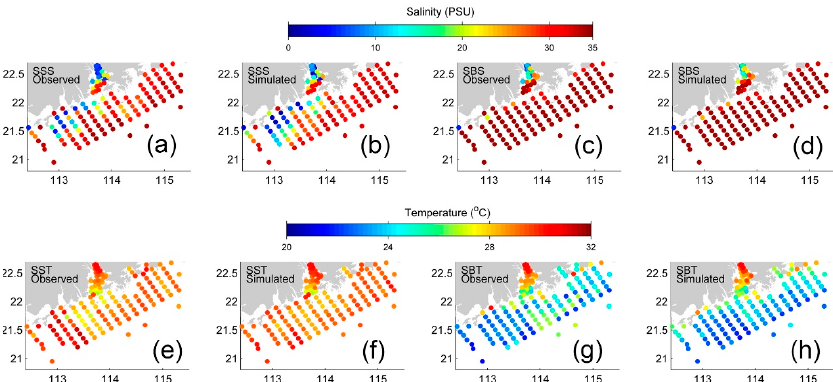
Figure 5. Comparisons of the observed and simulated salinity ( a – d ) and temperature ( e – h ) during summer 2006. SSS: Sea Surface Salinity, SBS: Sea Bottom Salinity, SST: Sea Surface Temperature, and SBT: Sea Bottom